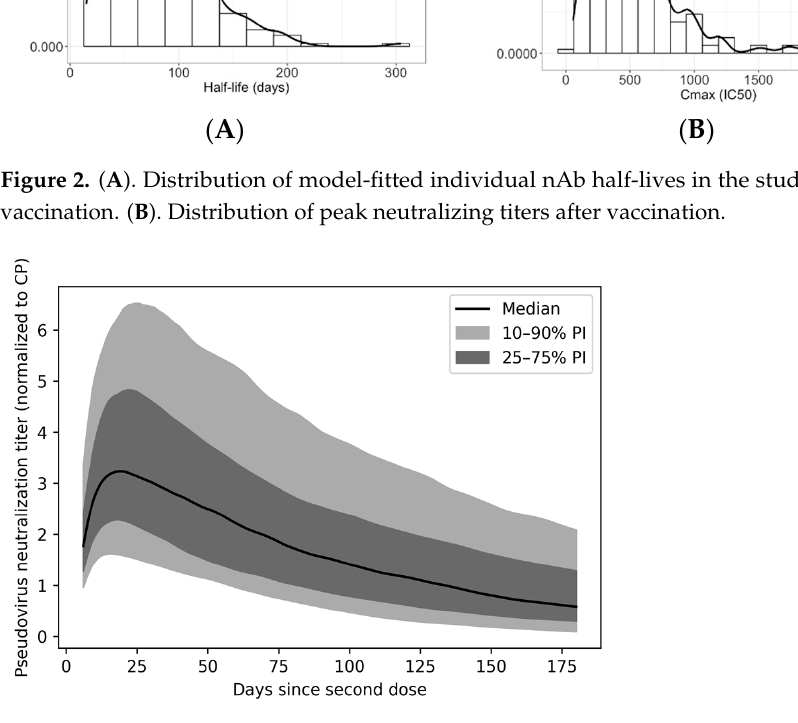
Figure 2. ( A ). Distribution of model- fi tt ed individual nAb half-lives in the study population after vaccination. ( B ). Distribution of peak neutralizing titers after vaccination.